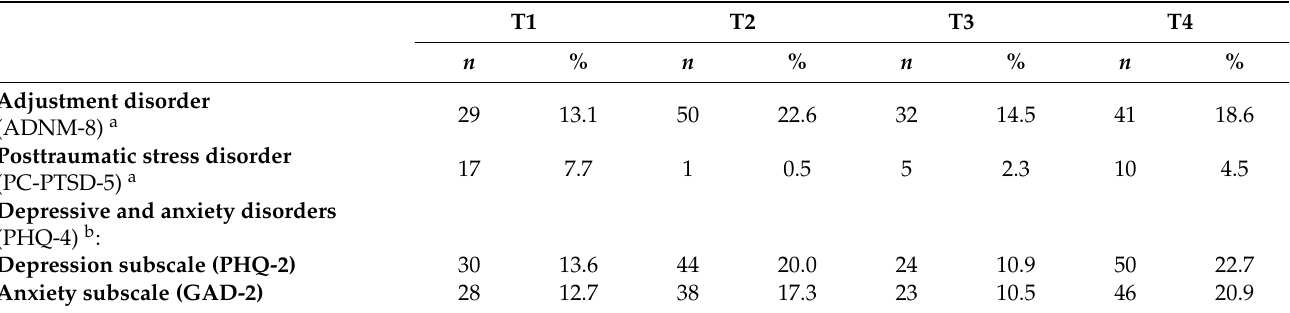
Table 4. Prevalence rates of probable mental health disorders at four timepoints.